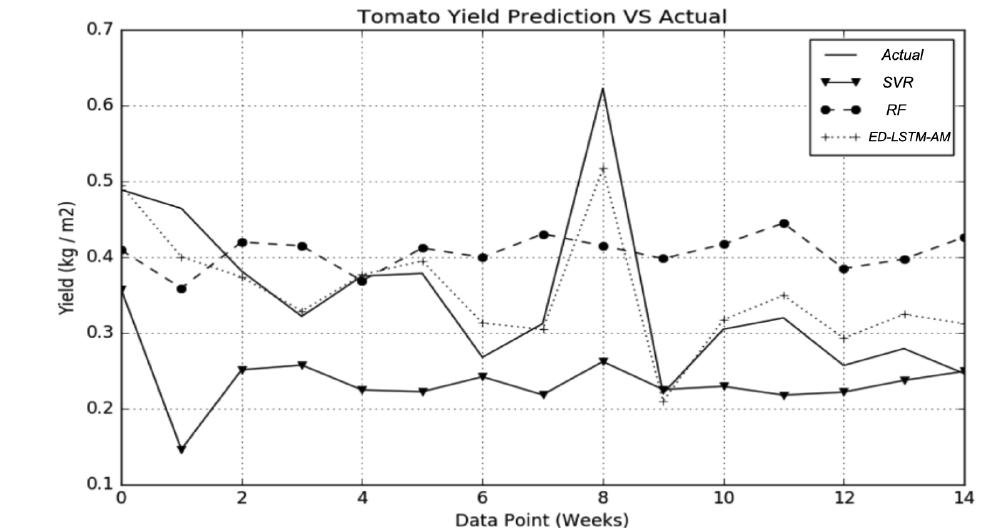
Figure 5. Performance comparison in tomato yield prediction (by ED-LSTM-AM and standard ML